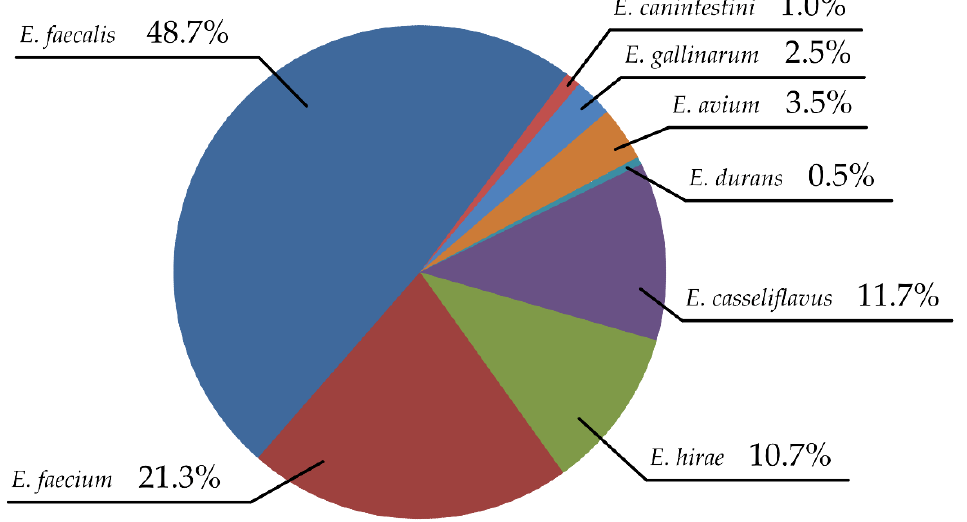
Figure 1. Distribution of Enterococcus strains isolated from dogs with chronic otitis externa.